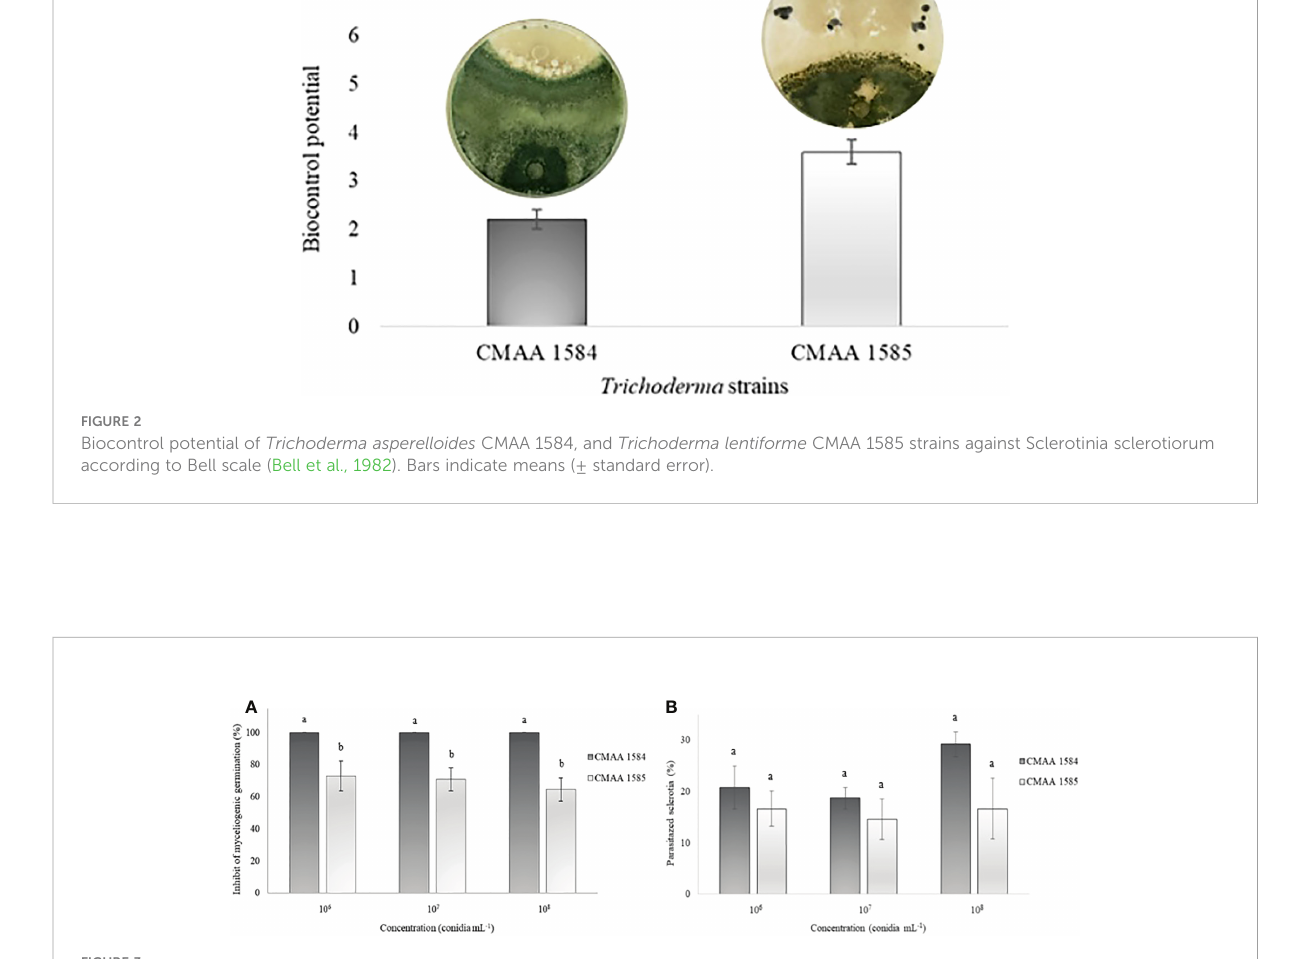
FIGURE 3 Ability of Trichoderma asperelloides CMAA 1584 and Trichoderma lentiforme CMAA 1585 strains to inhibit myceliogenic germination (A) and to parasitize (B) Sclerotinia sclerotiorum sclerotia by direct antagonism at different inoculum concentrations. *Bars indicate mean (± standard error). Means followed by the same letters do not differ from each other (Tukey test, p < 0.05).